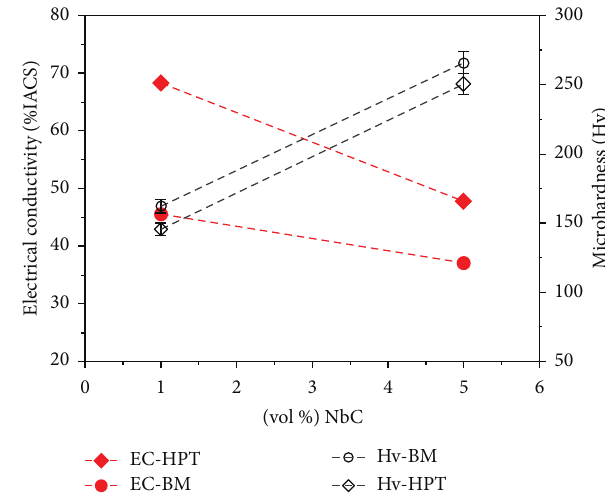
Figure 5: Comparison of electrical conductivity of Cu-NbC com- posites fabricated by HPT and BM methods; EC-HPT and Hv- HPT are electrical conductivity and microhardness of HPTed Cu- NbC composites, respectively; EC-BM and EC-BM are electrical conductivity and microhardness of milled Cu-NbC composites,